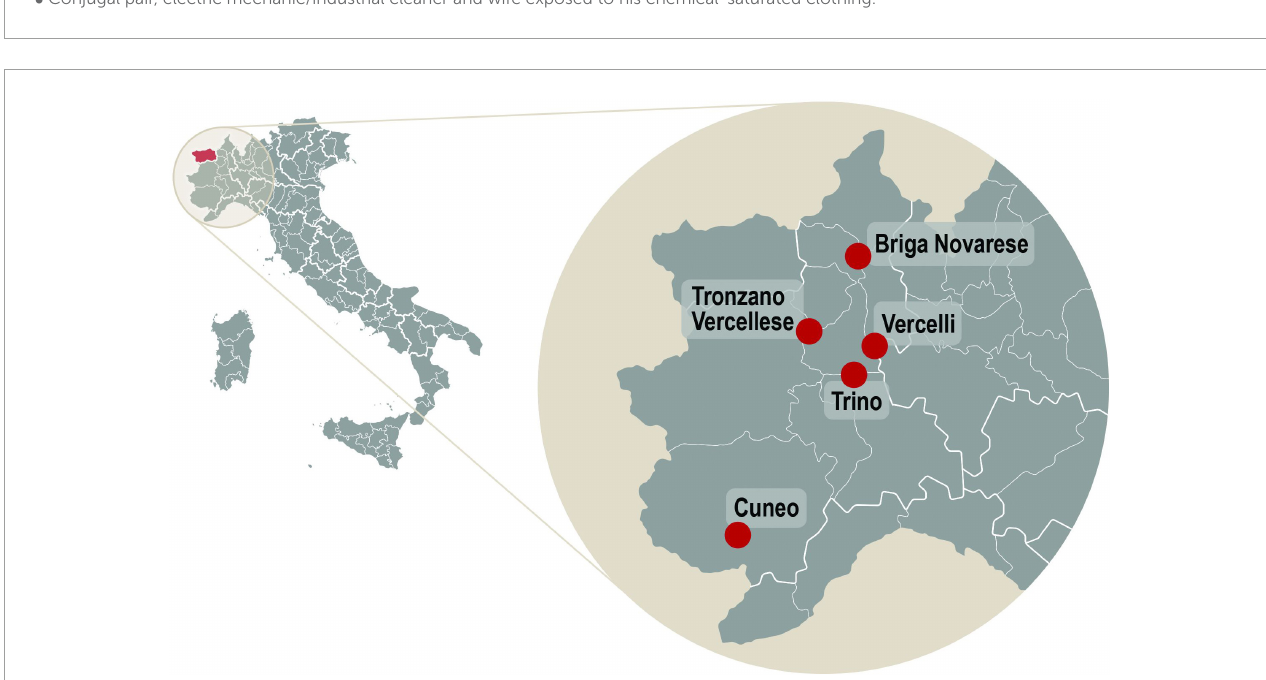
FIGURE1 Left image: Map of Italy (including the islands of Sardinia center left and Sicily, bottom ), showing the Aosta Valley in red (upper left) and nearby ALS hotspots (right) in Piedmont. The town of Acqui Terme is located ∼ 50 miles due east of Cuneo.